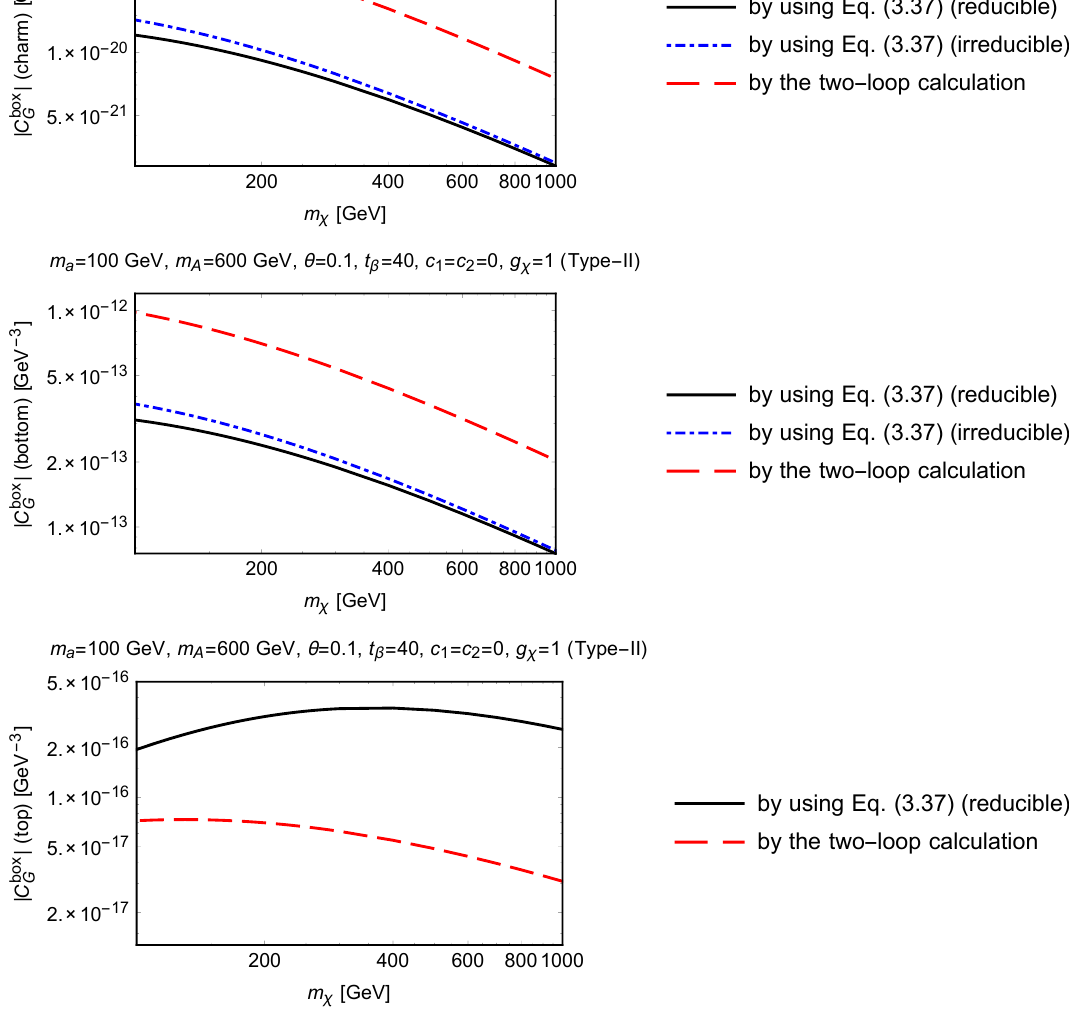
. The parameters are m a = G